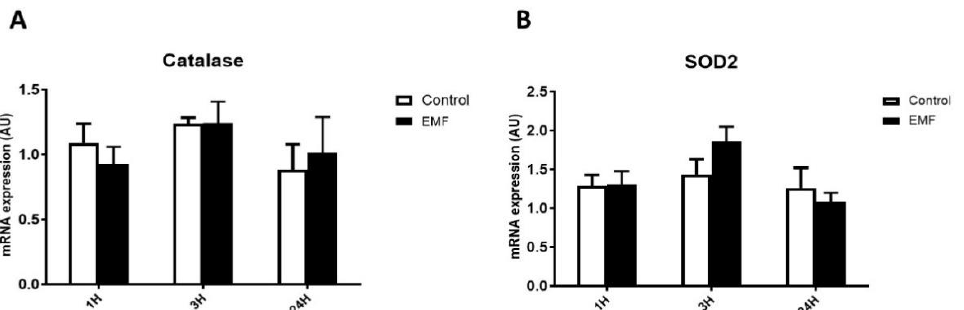
Figure 3. Effects of 915 MHz EMFs on antioxidant enzyme gene expression in cultured cardiomyocytes. Quantitative analysis of the mRNA expression levels of catalase ( A ) and SOD2 ( B ) in cardiomyocytes exposed to EMFs for 1 h, 3 h, and 24 h. The results present the mean ± SEM of three independent